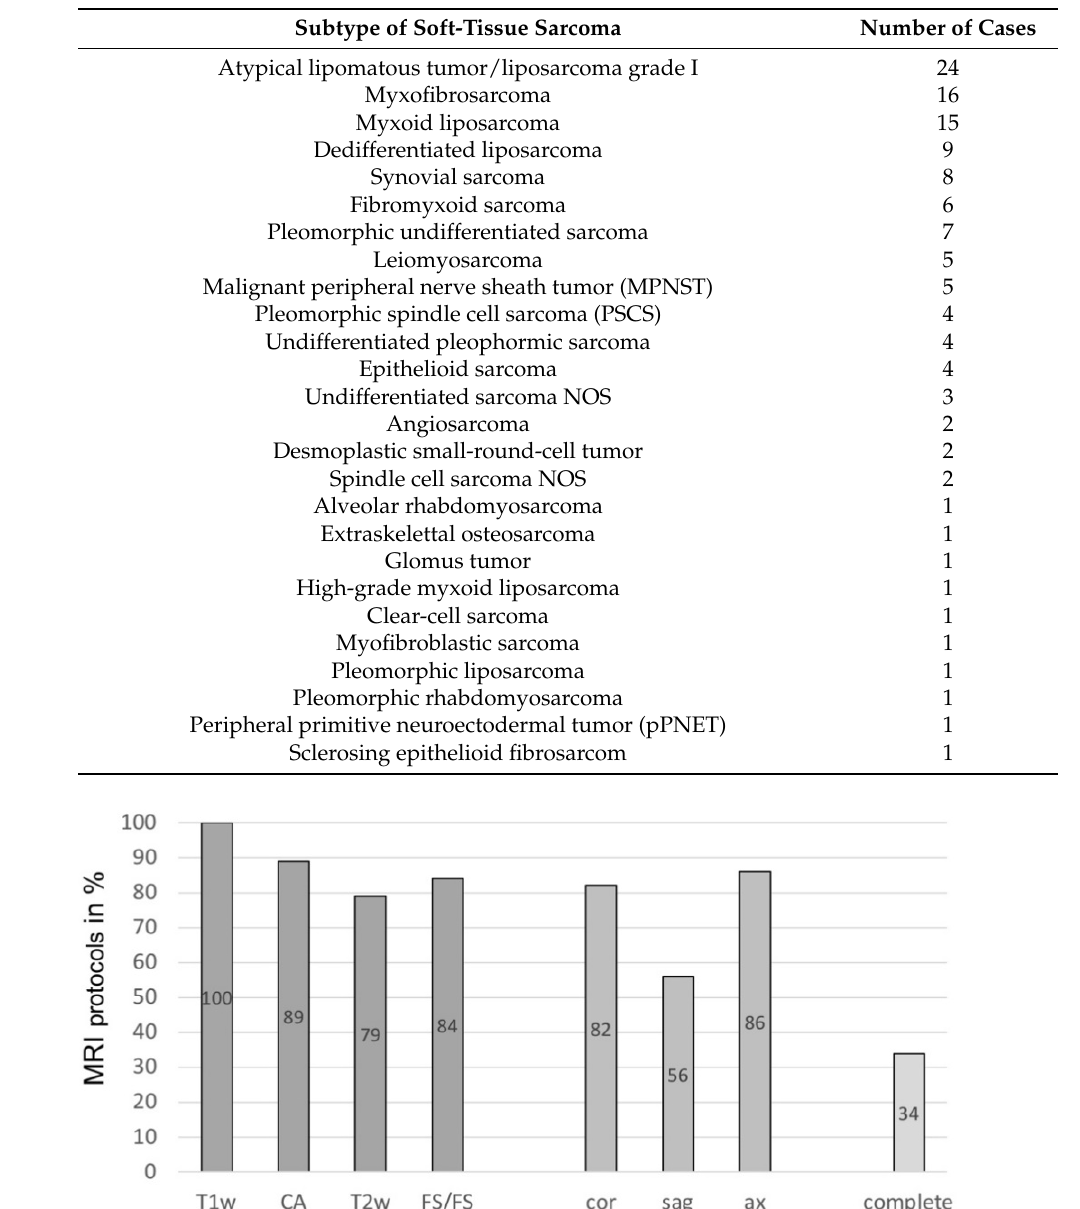
Table 1. Numbers of specific subtypes of soft-tissue sarcomas, according to final histopathological reports.